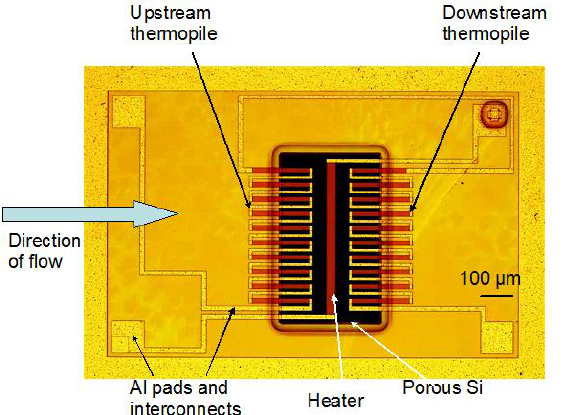
Figure 1. Schematic of the sensor surface area depicting the porous Si area, the heater and two series of thermocouples (upstream and downstream thermopile) and contact pads and interconnects. The flow direction is perpendicular to the heater and is indicated by the horizontal